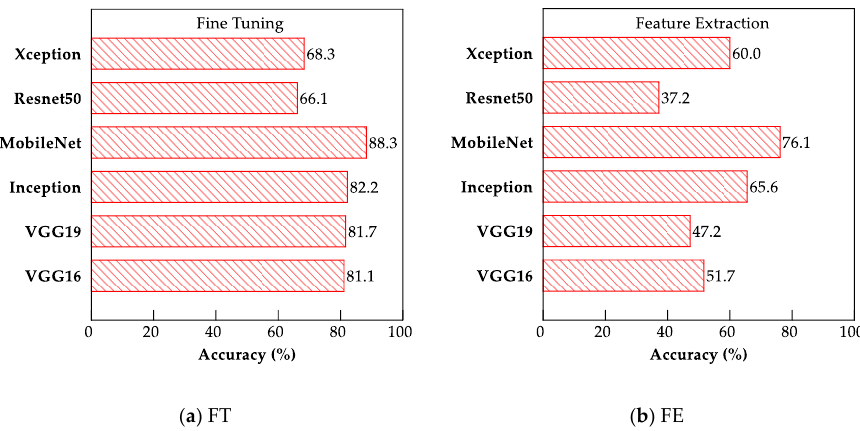
Figure 7. Bar charts showing testing accuracies for ( a ) FT and ( b ) FE of CNN models.